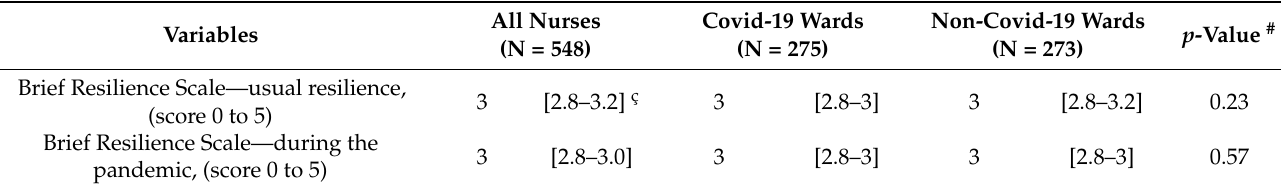
Table 4. Brief Resilience Scale (By Smith et al.,